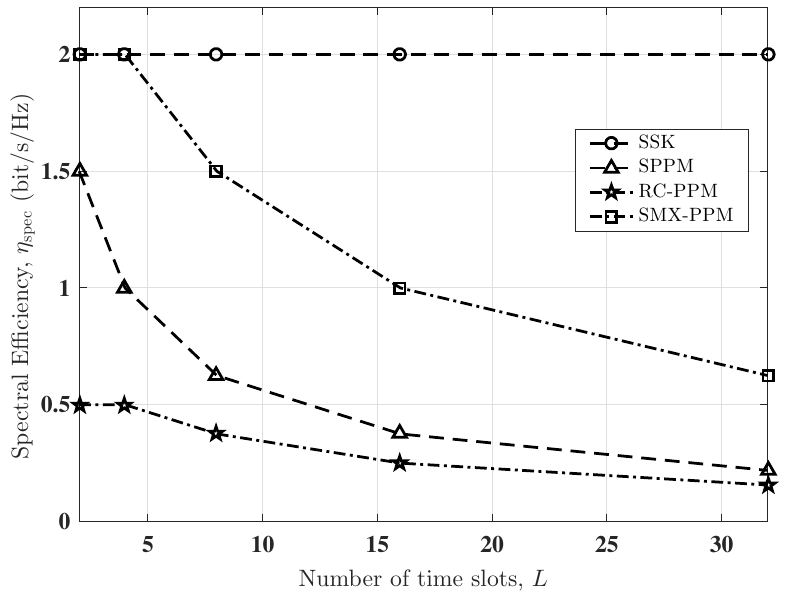
Figure 6. Spectral efficiency comparison of SPPM with space shift keying (SSK), repetition coding (RC)-PPM, and spatial multiplexing (SMX)-PPM for different values of L , using N t = 4, and under the strong AT